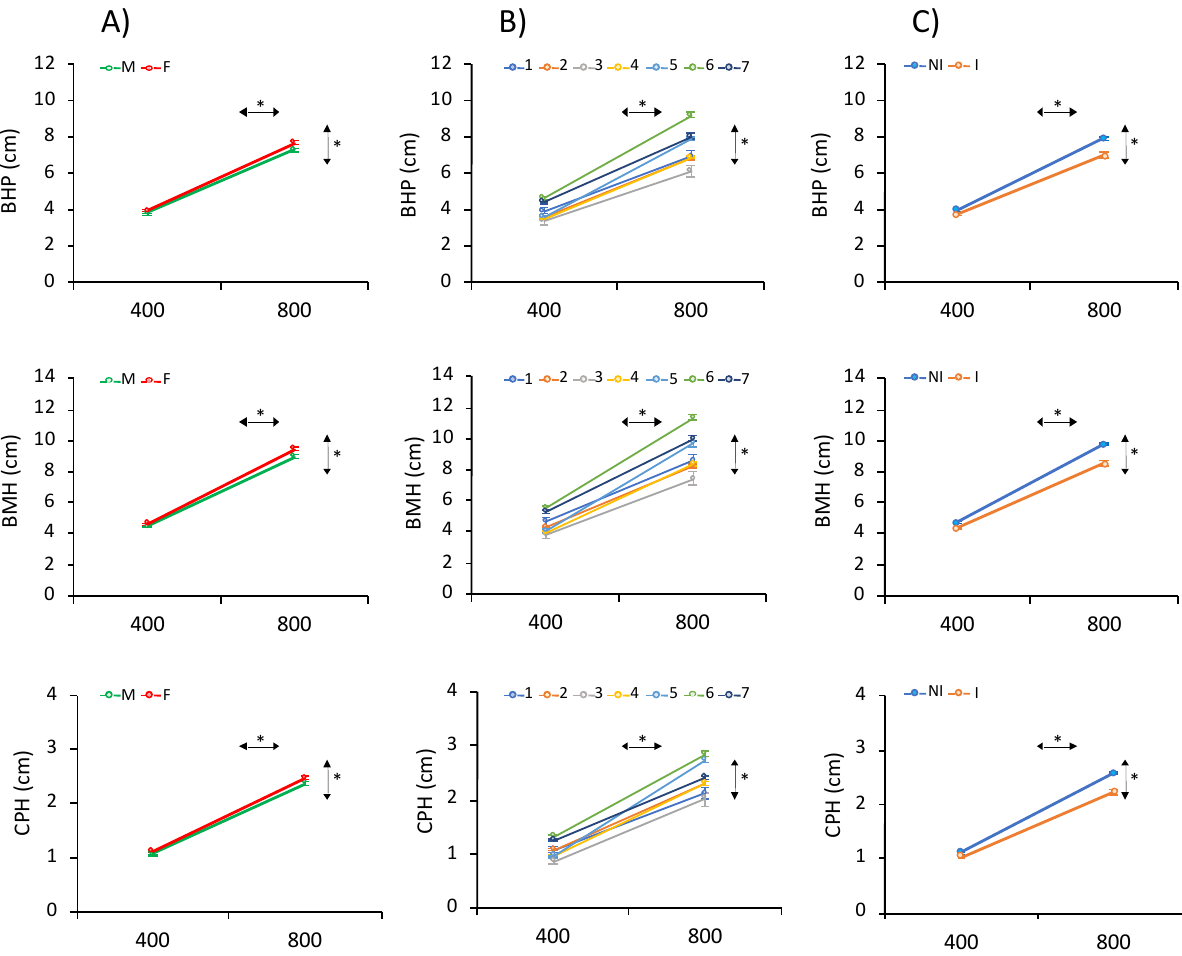
Figure 3. Estimated marginal means for height at the pectoral fin base (body height at the insertion of the pectoral fin (BHP), body maximum height (BMH) and caudal peduncle height (CPH) as determined by repeated-measures ANOVA at 400 and 800 days (d) for ( A ) gender (male: M; female: F), ( B ) Evaluation Batch (EB) (1–7) and ( C ) Amoebic disease (AD) (infected: I; non-infected: NI). The asterisks (*) on the horizontal or vertical arrows denote if within- or between-subject effects were